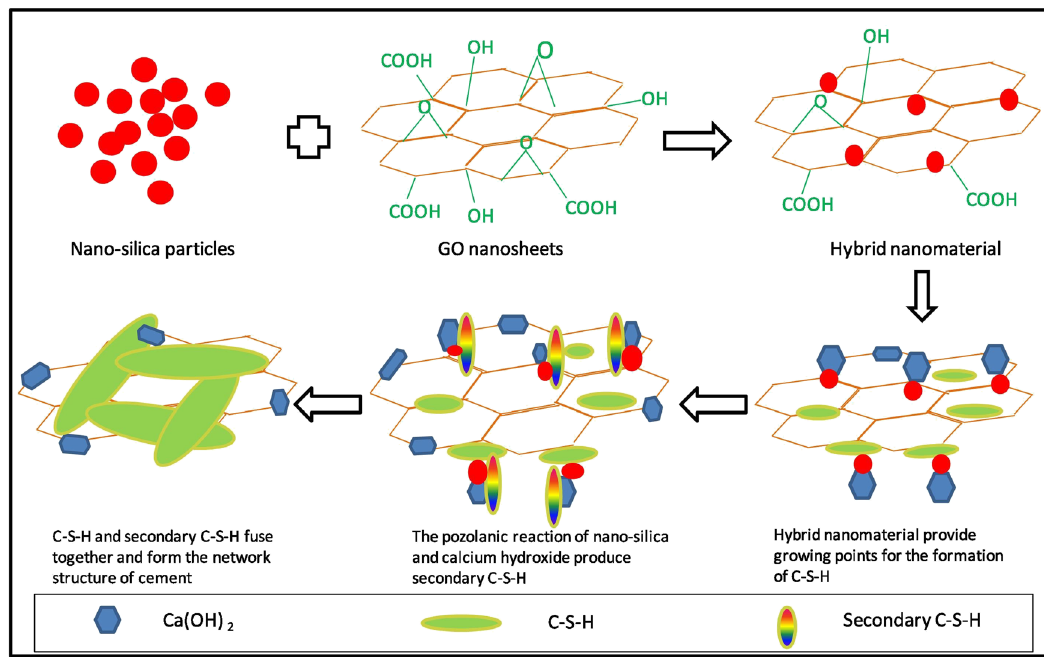
Figure 23: The sketch map of hybrid nanomaterials e ff ect on cement hydration process [ 133 ] .